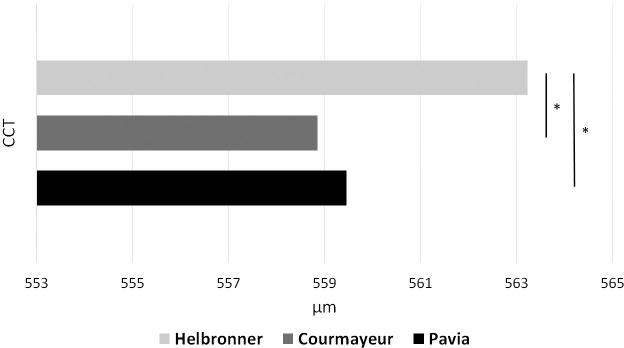
Central corneal thickness at three different altitudes.Changes of central corneal thickness measured in μm upon ascension from Pavia (PV, black bar), to Courmayeur (CM, dark grey bar), and Pointe Helbronner (PH, light grey bar). CCT increased in PH with respect to both PV and CM. *P-value indicates a statistically significant difference (p<0.05).